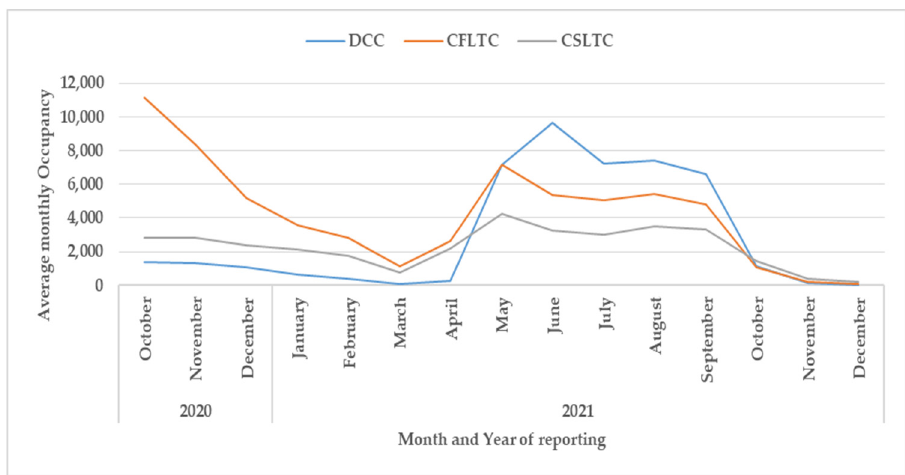
Figure 5. Monthly bed occupancy numbers for the three different types of field hospitals in Kerala,